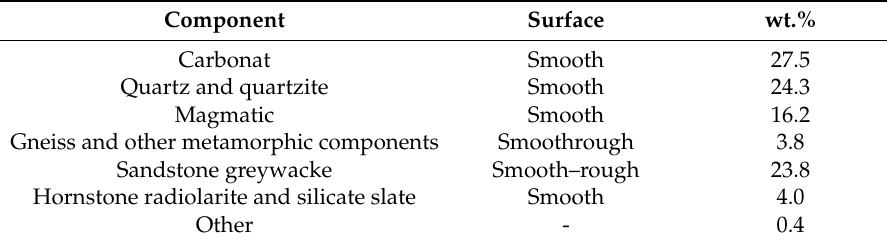
Table 2. Aggregate classification used in the concrete.